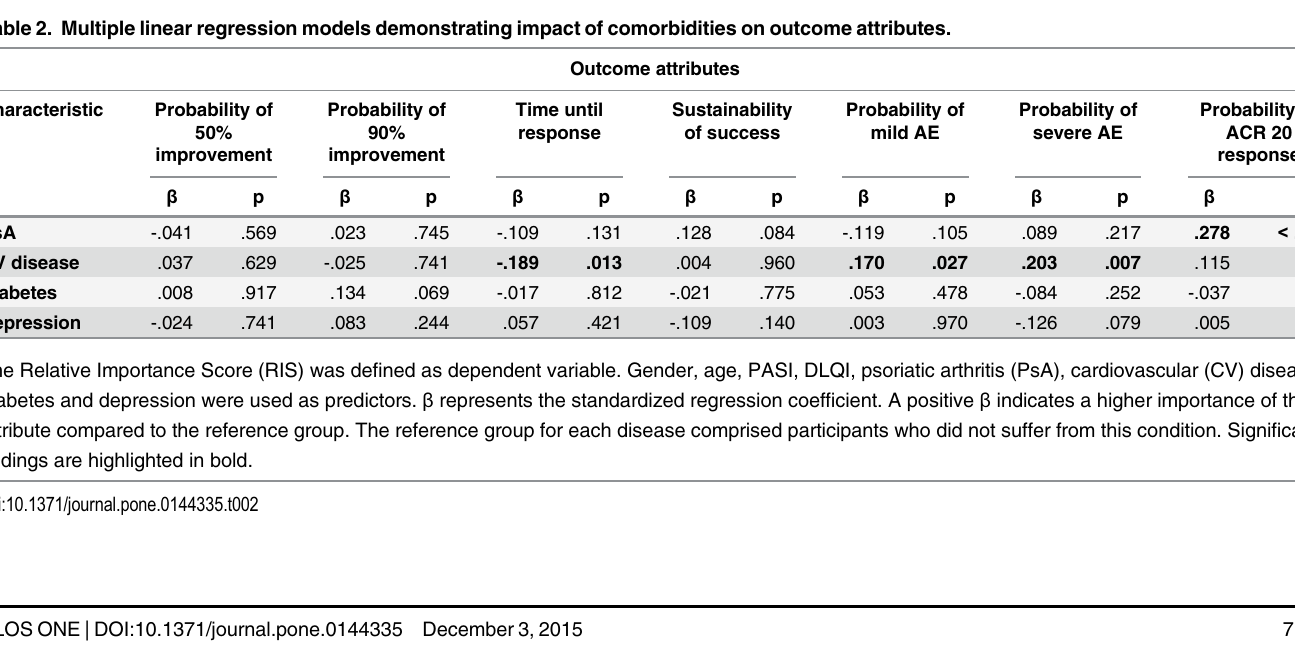
Table 2. Multiple linear regression models demonstrating impact of comorbidities on outcome attributes.